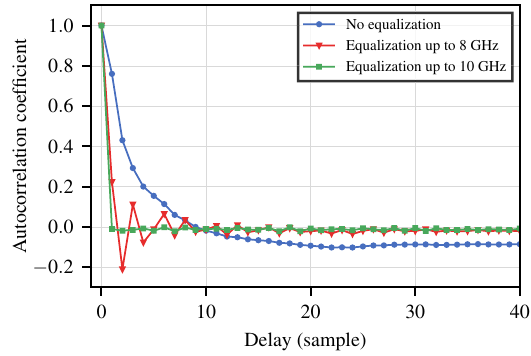
FIG. 8. The effect of the equalizers on the autocorrelation. The autocorrelation coefficients are averaged over 10 000 measured data